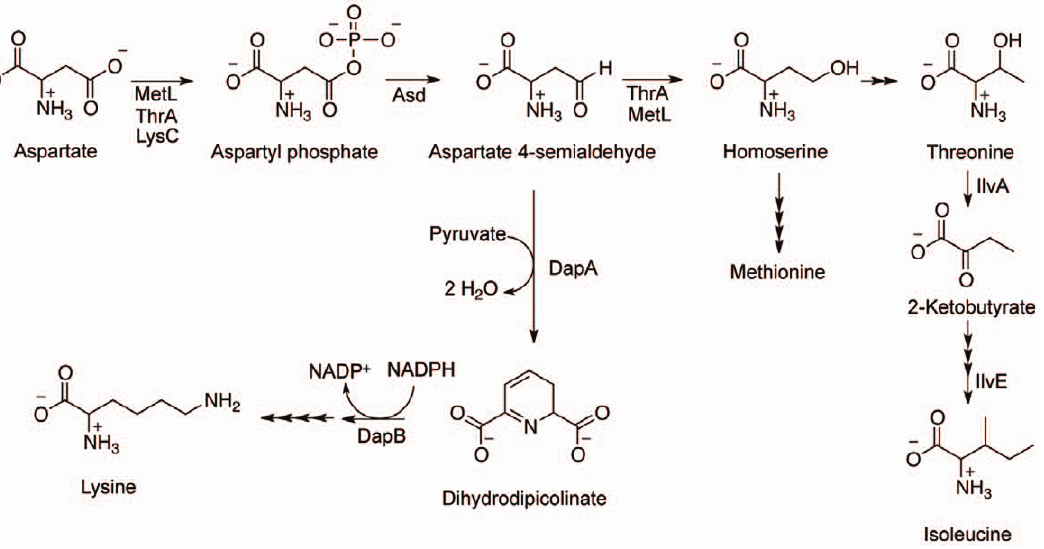
Figure 2. Pathway for synthesis of aspartate-derived amino acids. Aspartate is a precursor to lysine, methionine, threonine, and isoleucine, as depicted here. Aspartate 4-semialdehyde (ASA) is a branchpoint metabolite controlled by the activities of DapA, ThrA, and MetL.